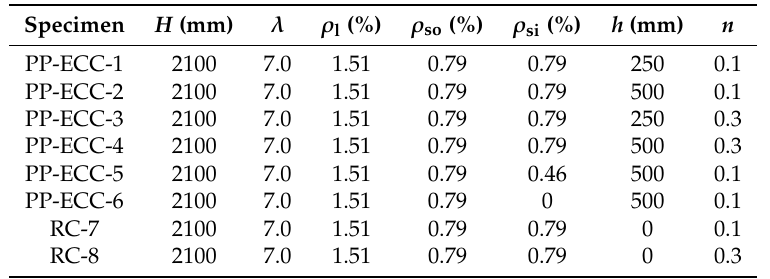
Table 3. Design parameters of specimens.